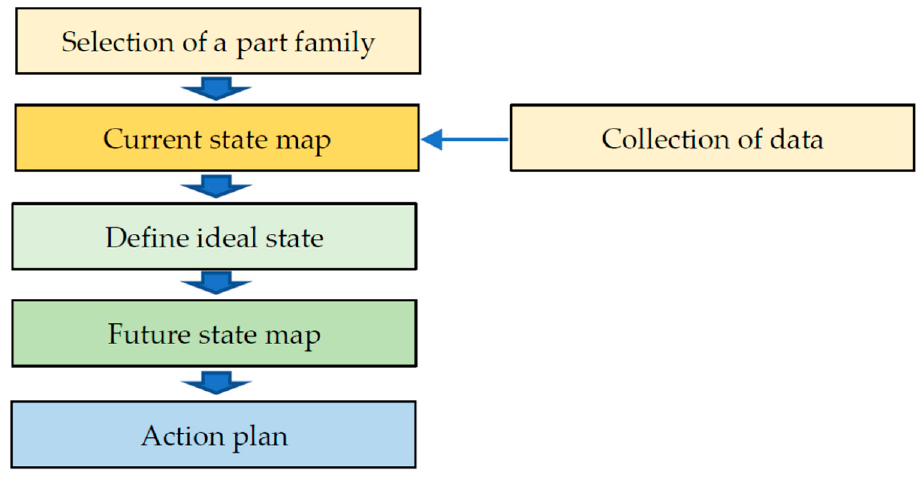
Figure 1. Steps involved in VSM.